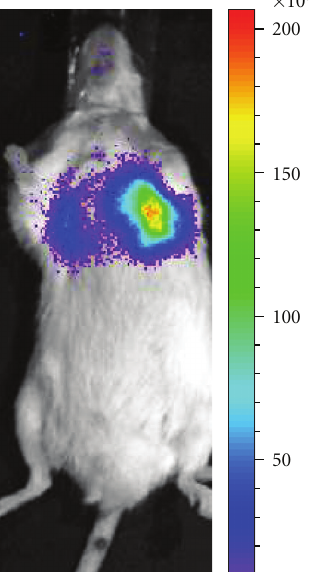
Figure 1: Bioluminescence imaging of invasive aspergillosis. The depicted mouse was immunosuppressed with cortisone acetate and infected intranasally with the bioluminescent A. fumigatus strain C3. Bioluminescence was acquired 28h after infection. Light emission is detected from both lung lobes indicating the establishment of bronchopulmonary aspergillosis. (Figure kindly provided by O.